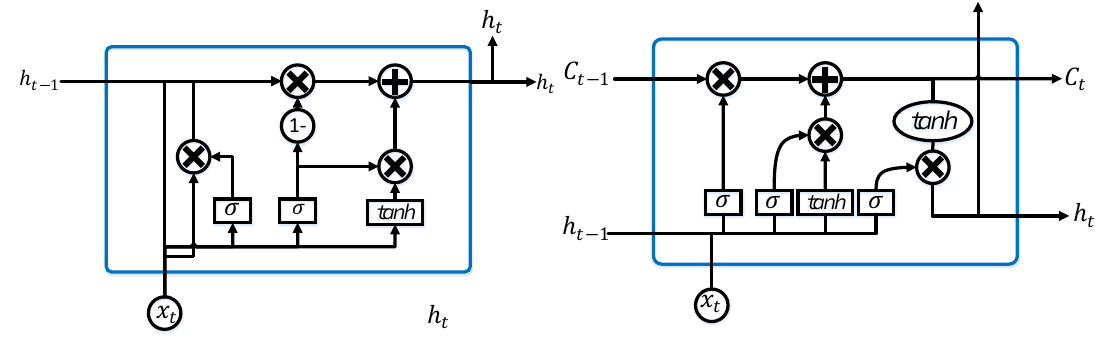
Figure 18. The left figure is a GRU cell while the right figure is a LSTM